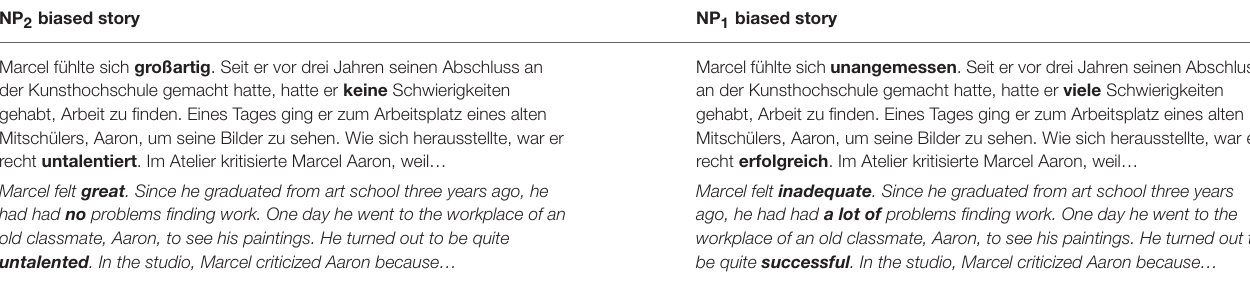
TABLE 1 | Two versions of an incomplete